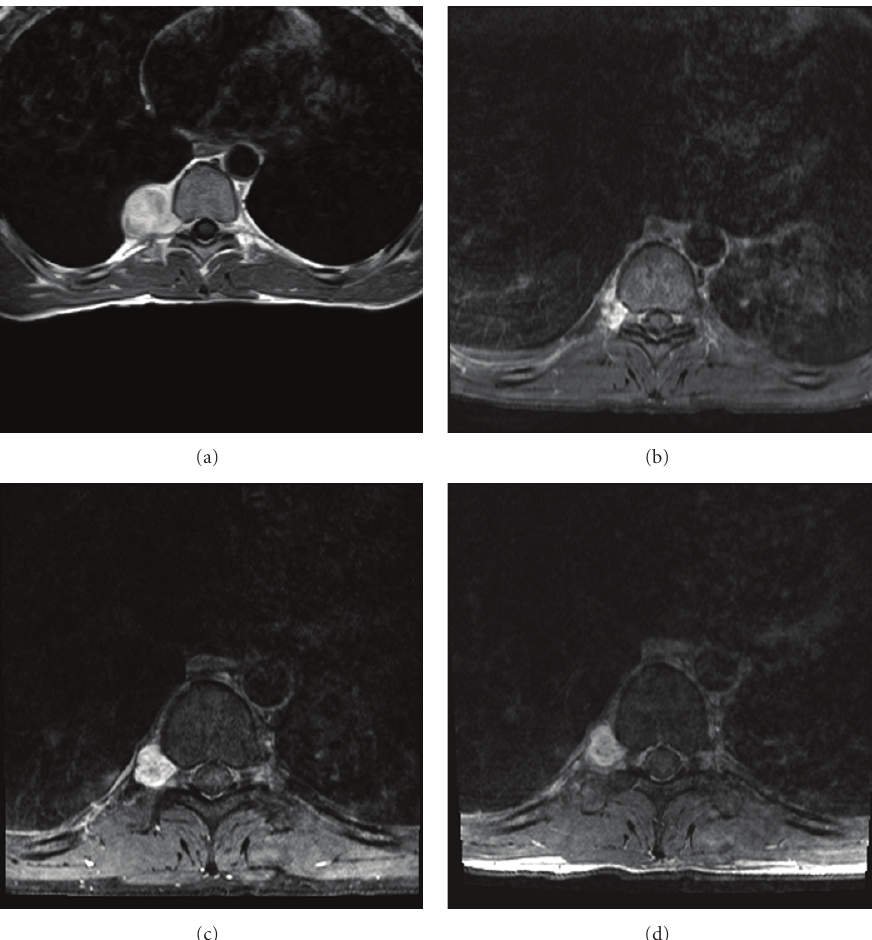
Figure 1: Magnetic resonance imaging of the thoracic spine with gadolinium contrast at the T9-10 region demonstrating an enhancing intradural extramedullary lesion exiting the neural foramen. (a) Preoperative MR imaging showing the initial size of the mass (3 . 8 × 3 . 6 × 4 . 5cm) with no spinal cord compression. (b) Immediate postoperative MR image demonstrating subtotally resected mass with a 1 . 5 × 1 . 0 × 1 . 5 cm residual within the right neural foramen. (c) MR imaging obtained 5 months postoperatively demonstrating progression of the enhancing component measuring 1 . 9 × 1 . 0 × 1 . 7 cm. (d) MR imaging with gadolinium enhancement showing stable disease 15 months after stereotactic